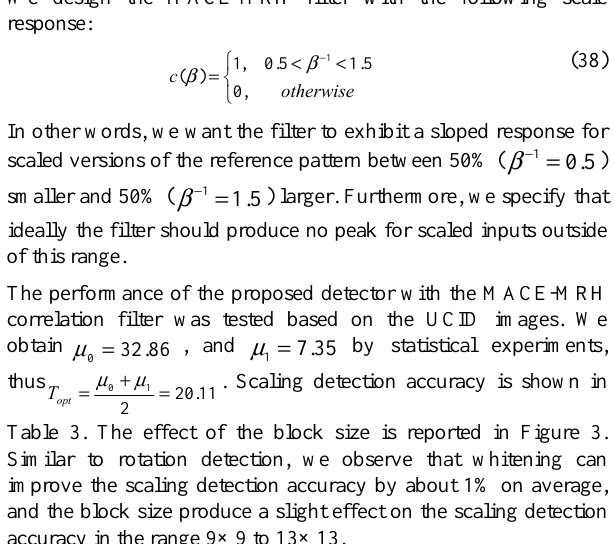
ideally the filter should produce no peak for scaled inputs outside of this range. The performance of the proposed detector with the MACE-MRH correlation filter was tested based on the UCID images. We obtain . Scaling detection accuracy is shown in Table 3. The effect of the block size is reported in Figure 3. Similar to rotation detection, we observe that whitening can improve the scaling detection accuracy by about 1% on average, and the block size produce a slight effect on the scaling detection accuracy in the range 9× 9 to 13×